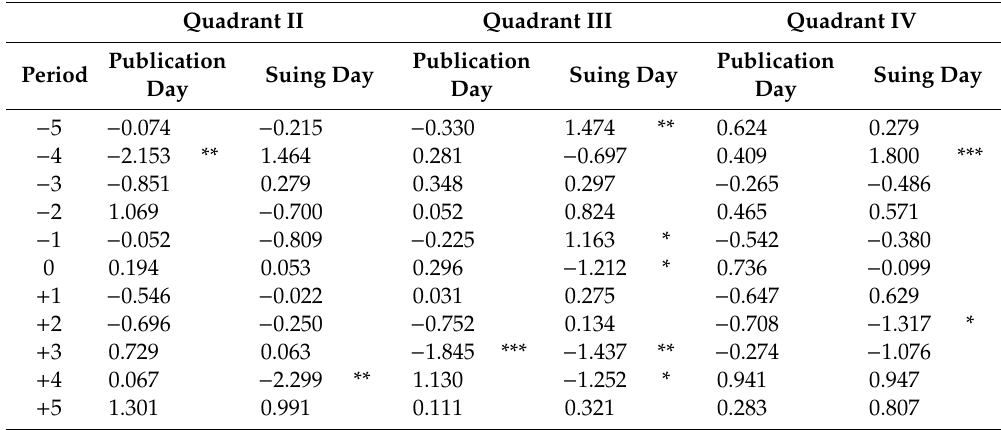
Table 2. ARs and CARs of patent litigation (plainti ff ) on the publication day the suing day in the di ff erent